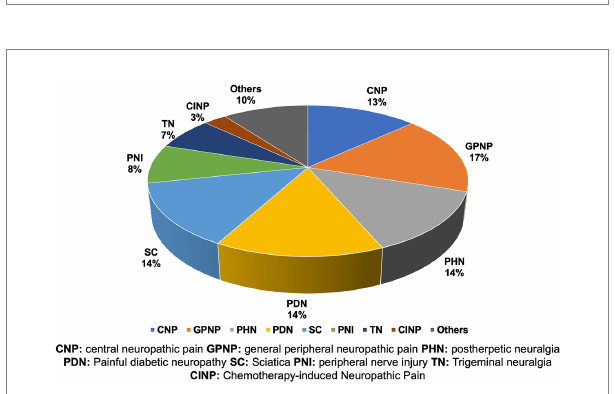
FIGURE 2 The proportion of different type of neuropathic pain in clinical